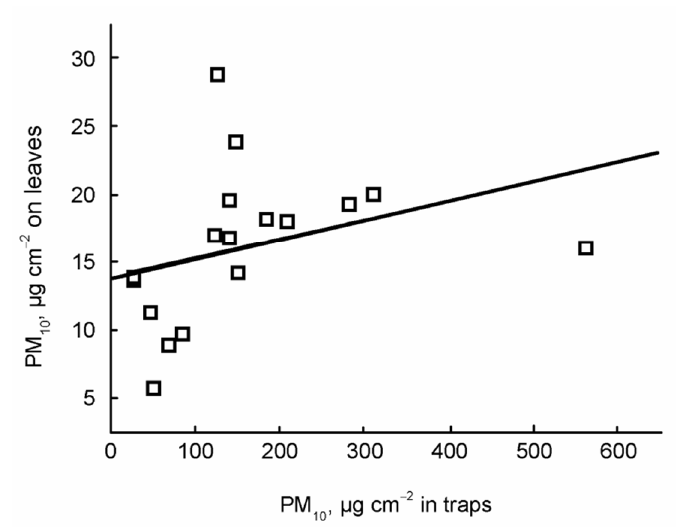
Figure 4. Scatter plot of PM concentration on leaves and dust traps based on the PM 10 . The regression line is also indicated.